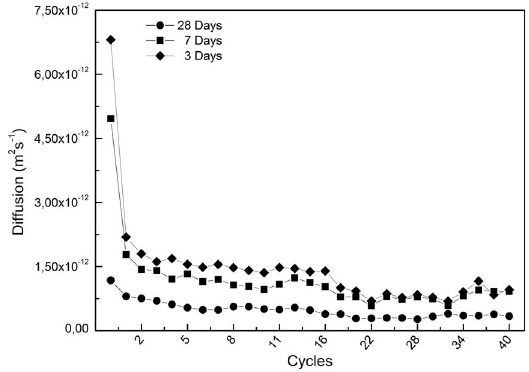
Figure 12. Warburg diffusion for different curing times.